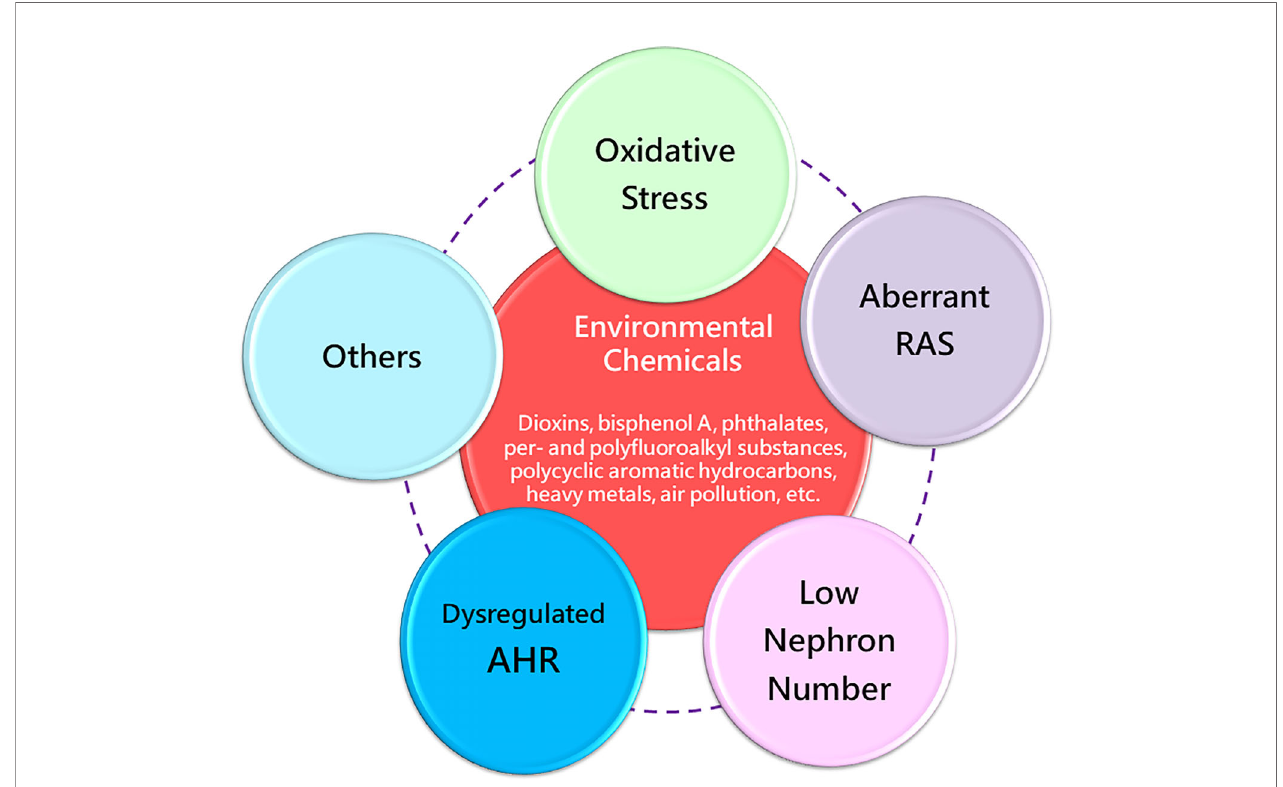
FIGURE 2 | Overview of the common mechanisms of renal programming in response to various environmental chemicals in early life. RAS, renin-angiotensin system; AHR, aryl hydrocarbon